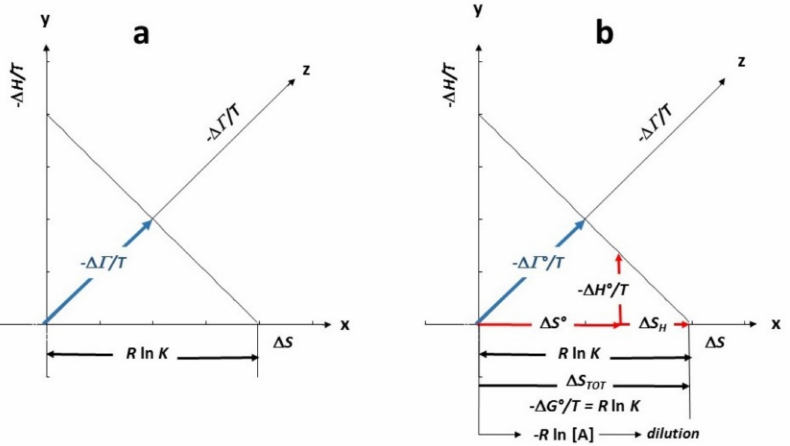
Figure 2. Vector representation of free energy in thermodynamic space ( a ) R ln K = ( − ∆ Γ /T ) / cos 45 ◦ = ( − ∆ G / T ); ( b ) R ln K = − ∆ G / T = − ∆ H / T + ∆ S